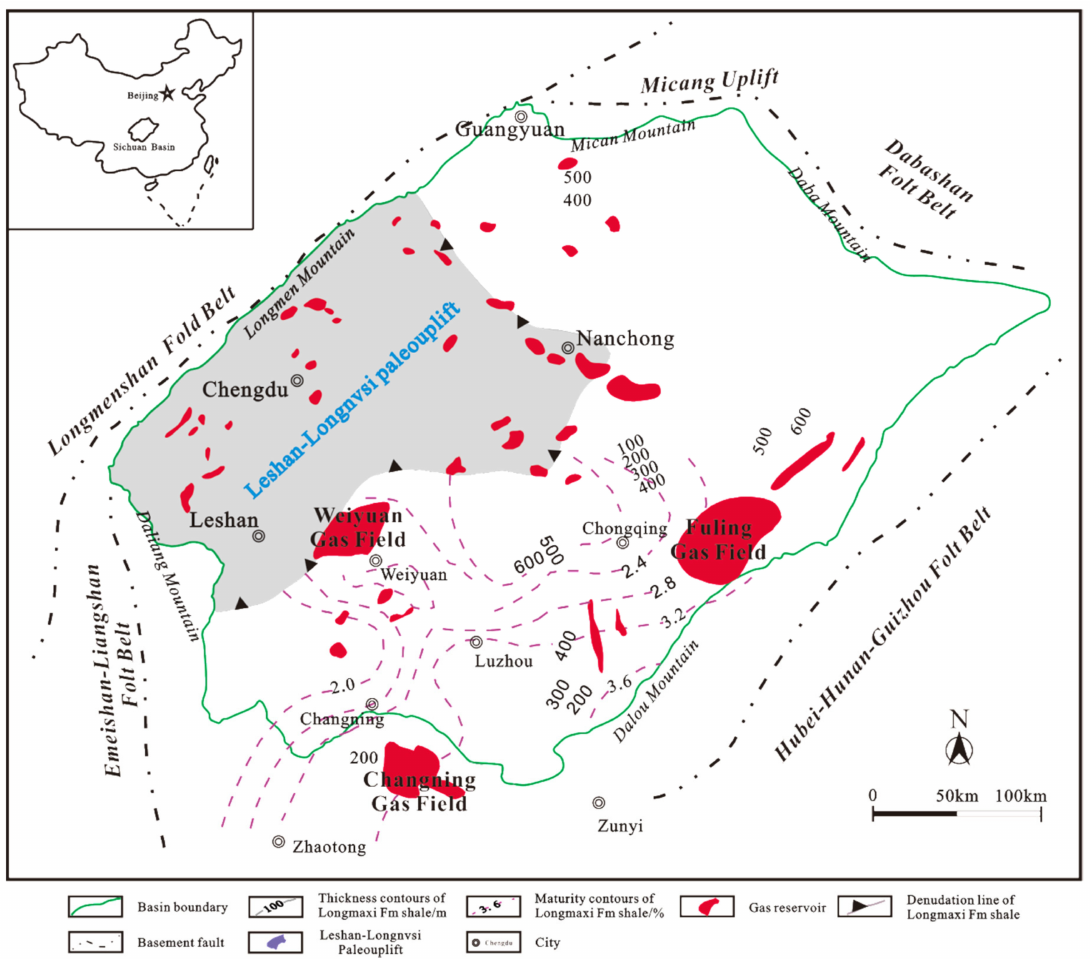
Figure 1. Geological sketch map of the Sichuan Basin, showing the locations of the main gas sampling sites, isolines of Ro values, and shale thickness of the Longmaxi